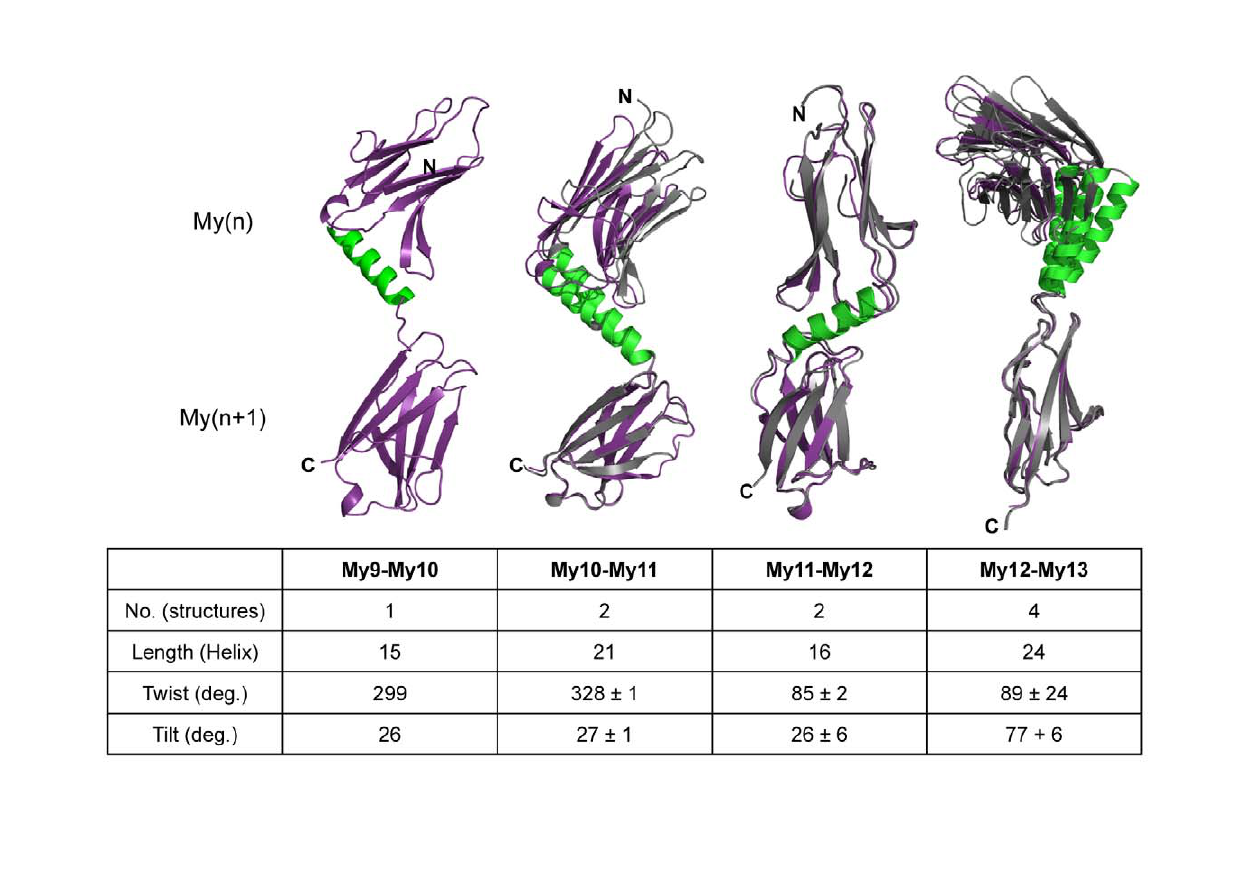
Figure 3. Limited flexibility of My–My domain arrangements, estimated from multiple crystal structures of identical My( n )–My( n + 1) domain tandems. The number of available structures, the length of connecting helices (number of residues), and the estimated tilt and twist angles [40], defining the arrangement of adjacent My domains, are listed. The standard deviations of these angles provide an estimate of the level of My–My domain flexibility observed. Each superposition uses the C-terminal My domain as the basis for superposition. The template structure is color-coded as in Figure 1, and the remaining superimposed structures are grey. The N- and C-termini are labeled.